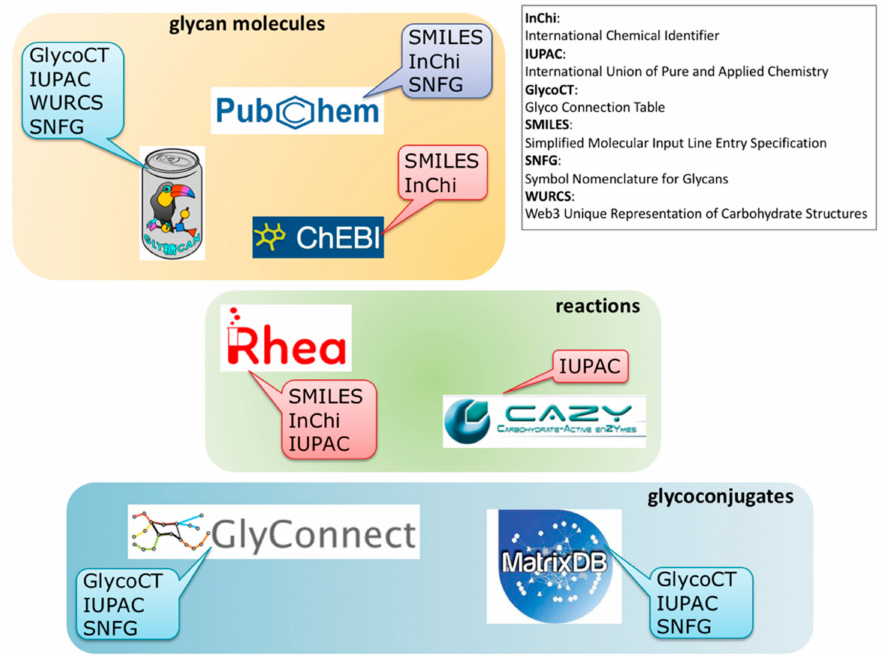
Figure 6. Variety of (in)compatible molecule and reaction encoding formats associated with each database in each category (molecules / reactions / glycoconjugates) hindering smooth